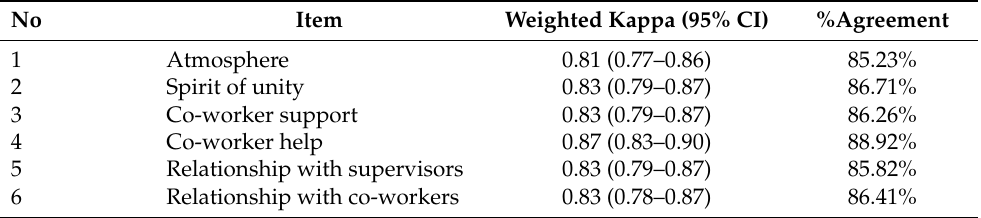
Table 2. Weight Kappa and percentage agreement for each item of the DCSQ Support scale.